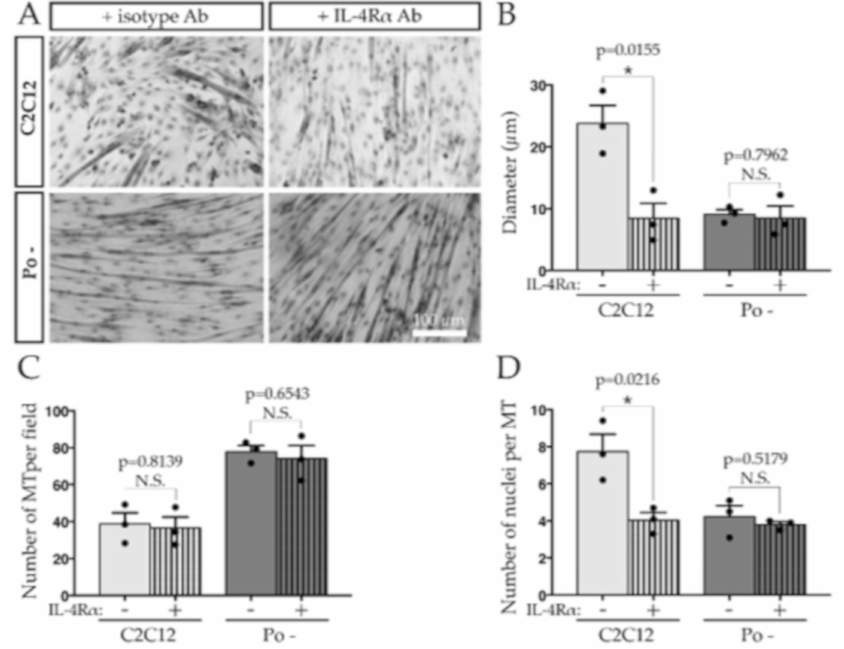
Figure 6. IL-4R α is involved in the MT growth. Neutralizing assay with anti-IL-4R α antibody on WT C2C12 cells generated thin and elongated MT like in Po –, observable at 120 h ( A ). WT C2C12 MT incubated with anti-IL-4R α antibody during di ff erentiation time course presented a lesser diameter than C2C12 untreated cells, similar to the diameter of Po – MT ( B ). Anti-IL-4R α antibody treatment did not impact the number of MT per field in any cases ( C ) but in C2C12 treated cells, the number of nuclei per MT decreased and became similar to Po – one ( D ). Experiments were conducted in biological triplicates. Bar graphs represented means ± SEM. In B , C and D , each mean of replicates was symbolized by a dark dot. Statistical analyses were performed using a two-tailed Student test, which compared cell lines treated or not with anti-IL-4R α antibody. * p < 0.05. N.S., not